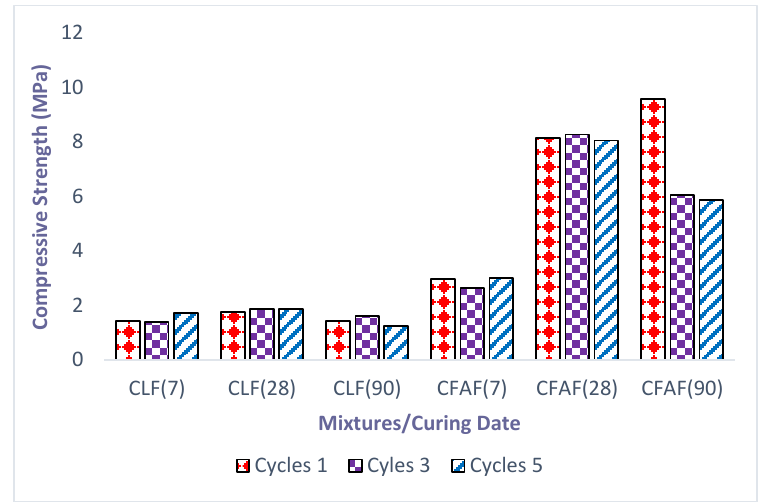
Figure 4. Evolution strength for all specimens.